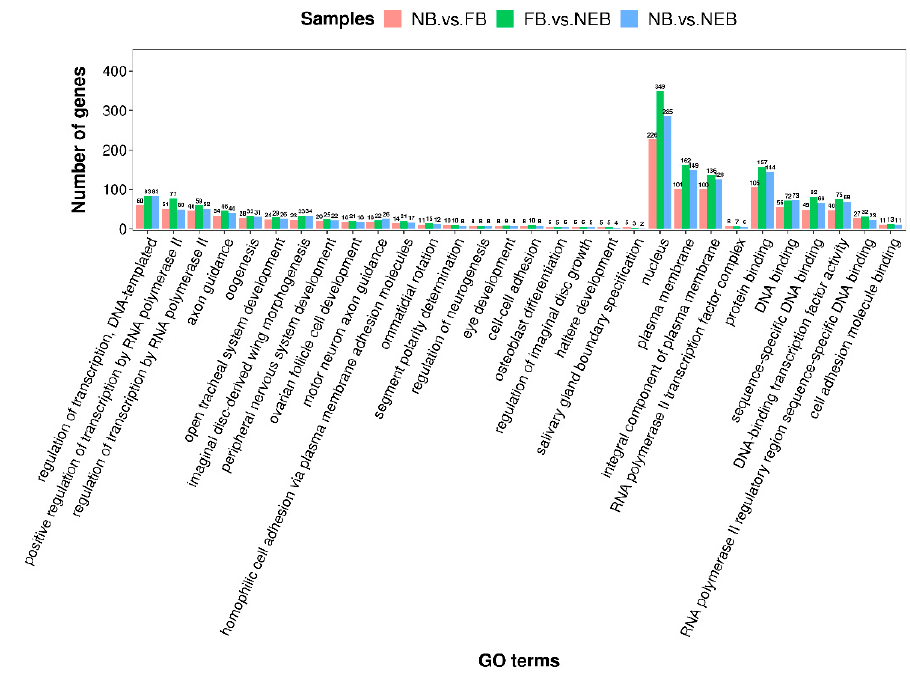
Figure 4. Gene ontology (GO) enrichment analysis of predicted target genes of the differentially expressed miRNAs identified in the NB vs. FB comparison, NB vs. NEB comparison, and FB vs. NEB comparison. NB: nurse bee, FB: forager bee, NEB: newly-emerged bee.